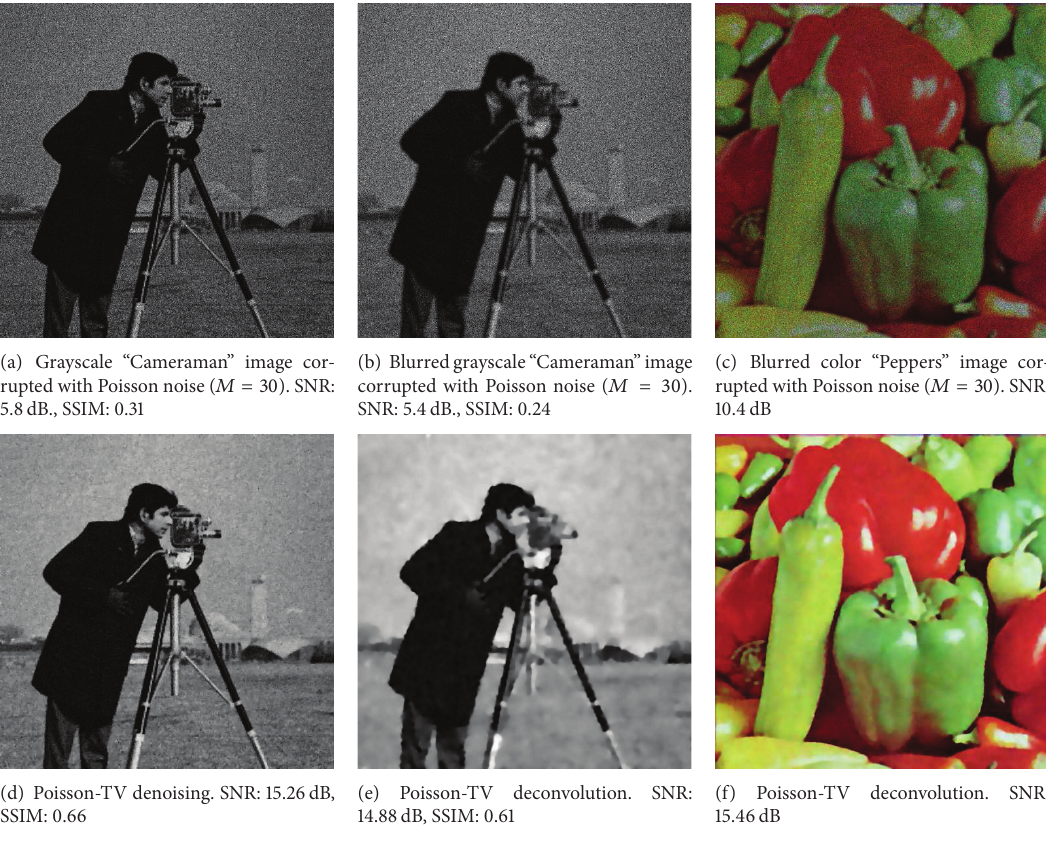
Figure 3: Denoising and deconvolution with the Poisson TV via [108] (a spatially adaptive algorithm).